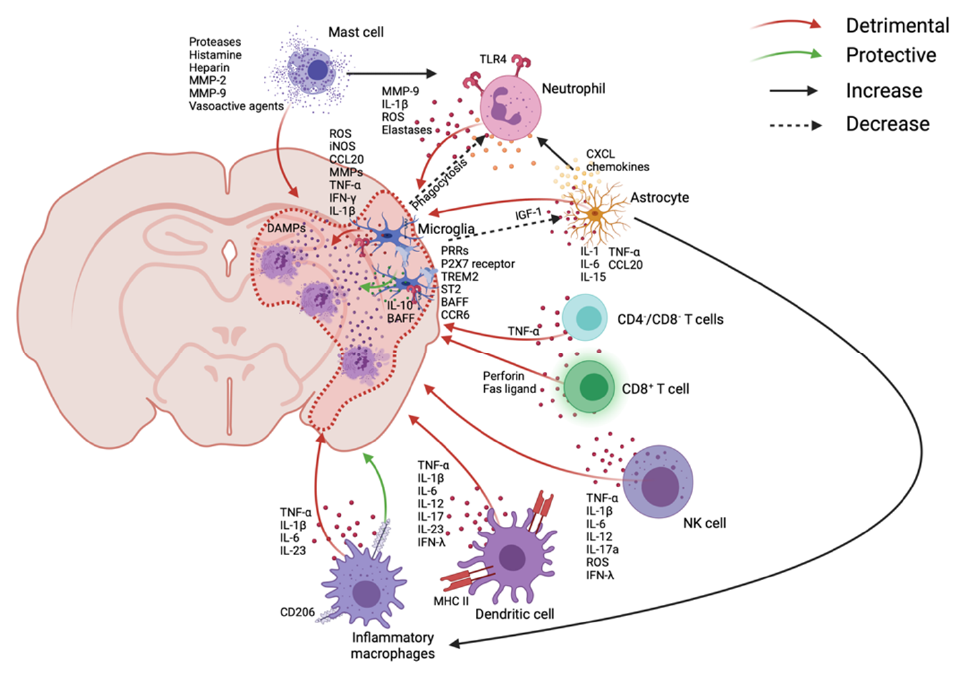
Figure 1. Schematic diagram of the immune responses immediately (<24 hours) after stroke onset (created with BioRender.com).